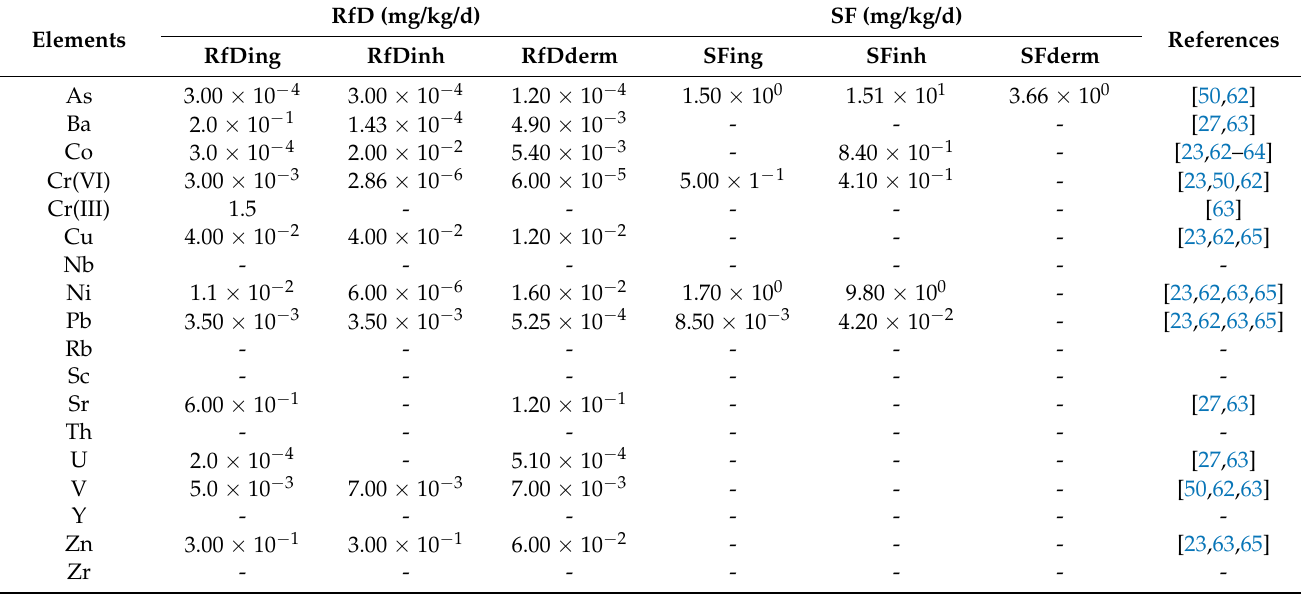
Table 11. Reference doses for non-cancer risks and slope factors for cancer risk